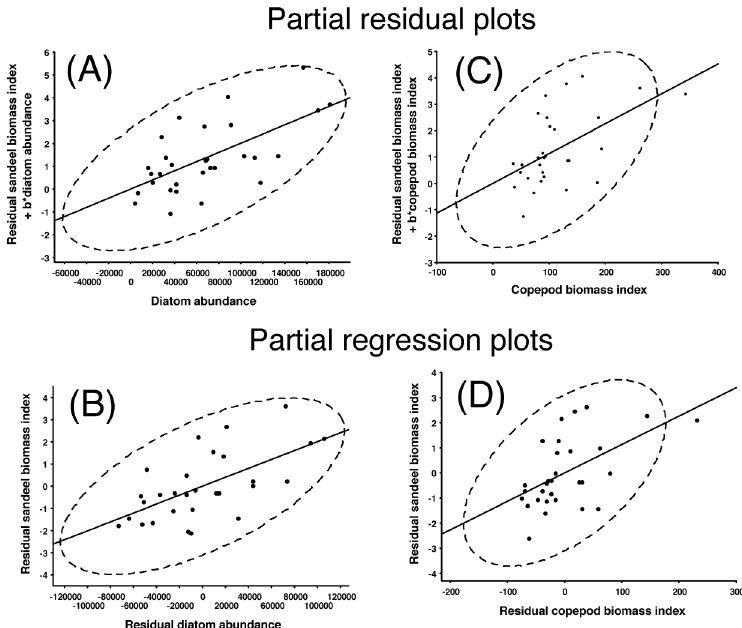
Fig. A2. Partial residual and partial regression plots from data in Fig. 3 of Frederiksen et al. (2006). The graphs were obtained from a multiple regression model that included year, diatom abundance and copepod abundance. The partial plots for year are in Fig. 1B in the printed part of this paper. (A) partial residual plot for diatom abundance, (B) partial regression plot for diatom abundance, (C) partial residual plot for copepod biomass and (D) partial regression plot for copepod biomass. Note the small difference between partial residual and partial regression plots due to the low correlation among predictors (see main text). To facilitate the visual assessment of the scatter of points around the line, we show the 95% predicting ellipse (dashed line) in all partial